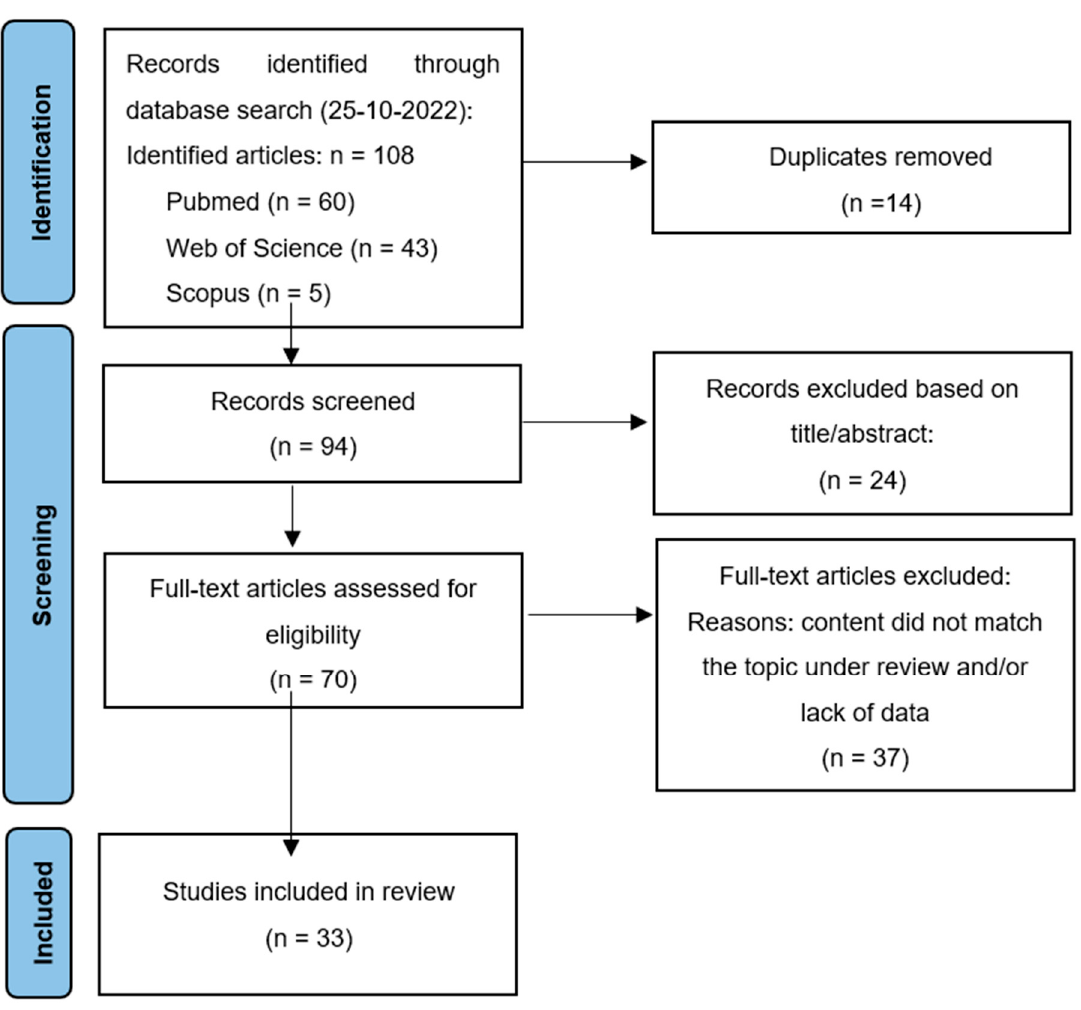
Figure 5. PRISMA diagram of study selection process for this review.